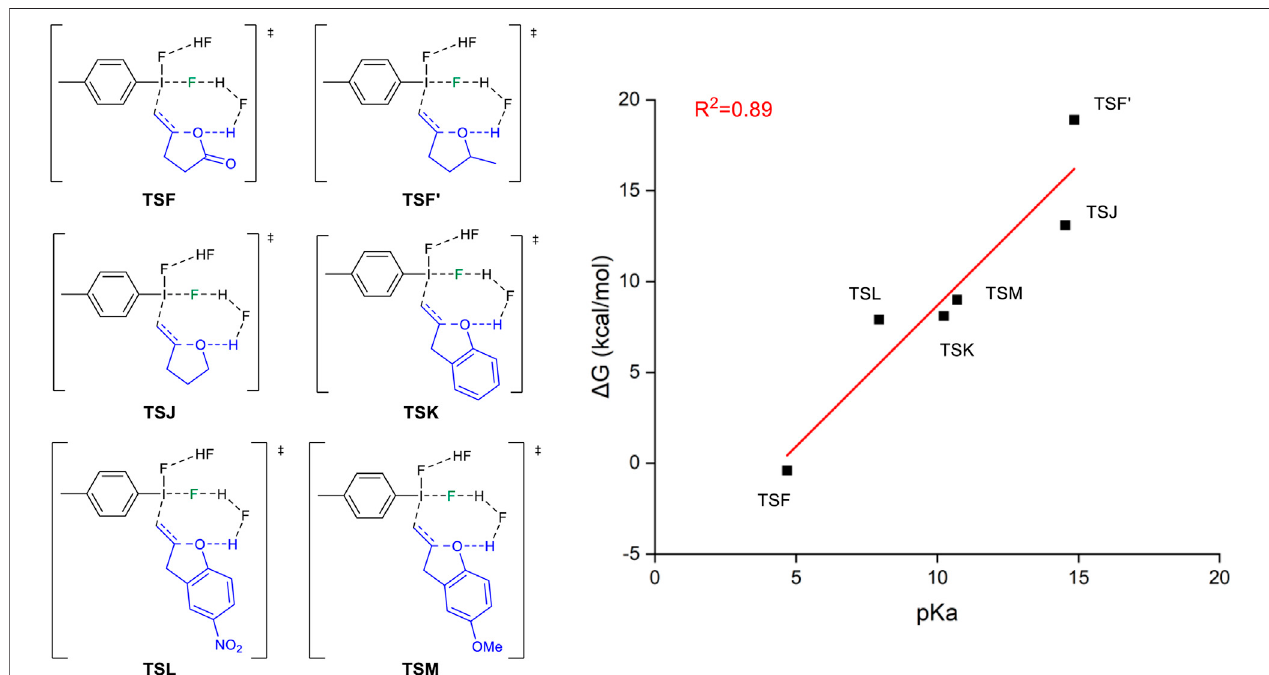
FIGURE 6 | Relationship between 5-exo-tet cyclized energy barriers of selected reactants with different p K a values.